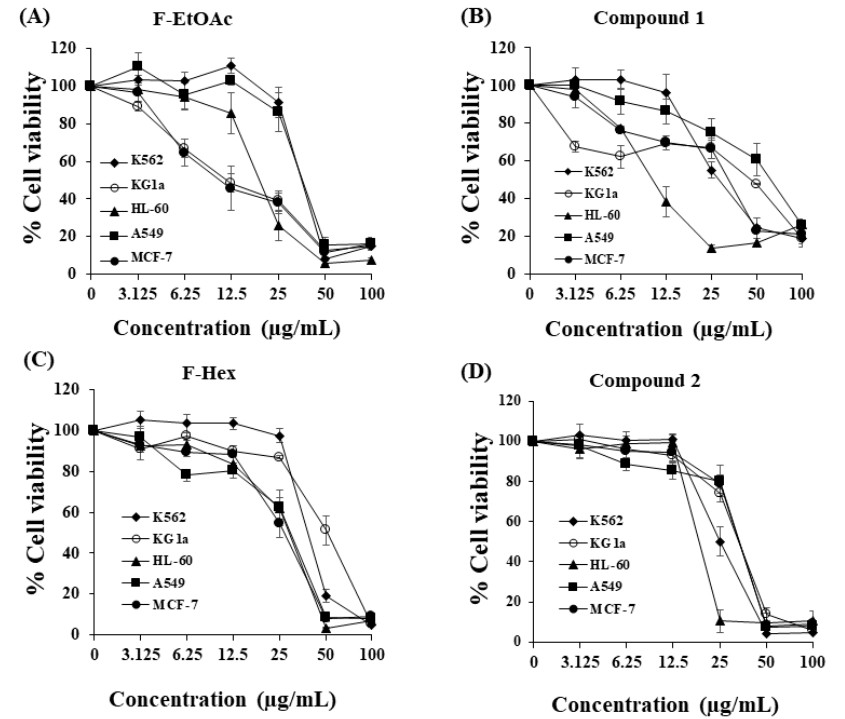
Figure 3. Cytotoxicity of crude fractional extracts and pure compounds from C. comosa to cancer cell lines. K562, KG-1a, HL-60, A549, and MCF-7 cells were treated with ( A ) ethyl acetate fraction (F-EtOAc), ( B ) compound 1 , ( C ) hexane fraction (F-Hex), or ( D ) compound 2 for 48 h. Cell viability was determined using the MTT assay. Each point represents the mean ± standard deviation (SD) of three independent experiments, each performed in triplicate.